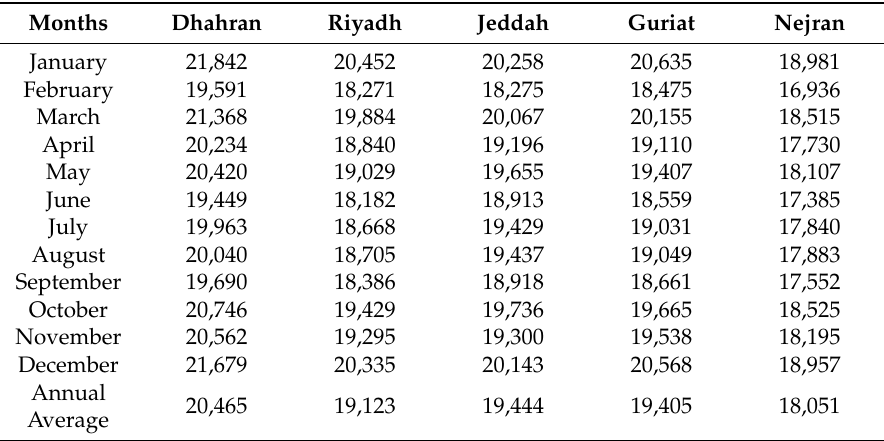
Figure 11. Annual power exported to grid for all sites. Table 3. Monthly power exported to grid for all sites (MWh).